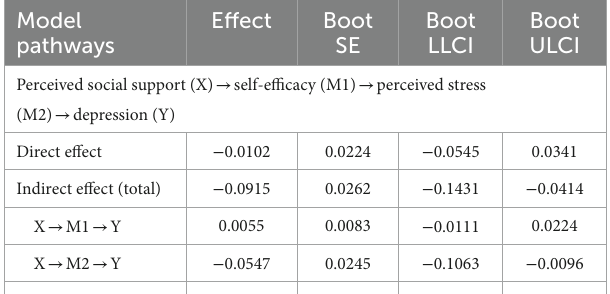
TABLE 4 Examination of chain mediating effects.